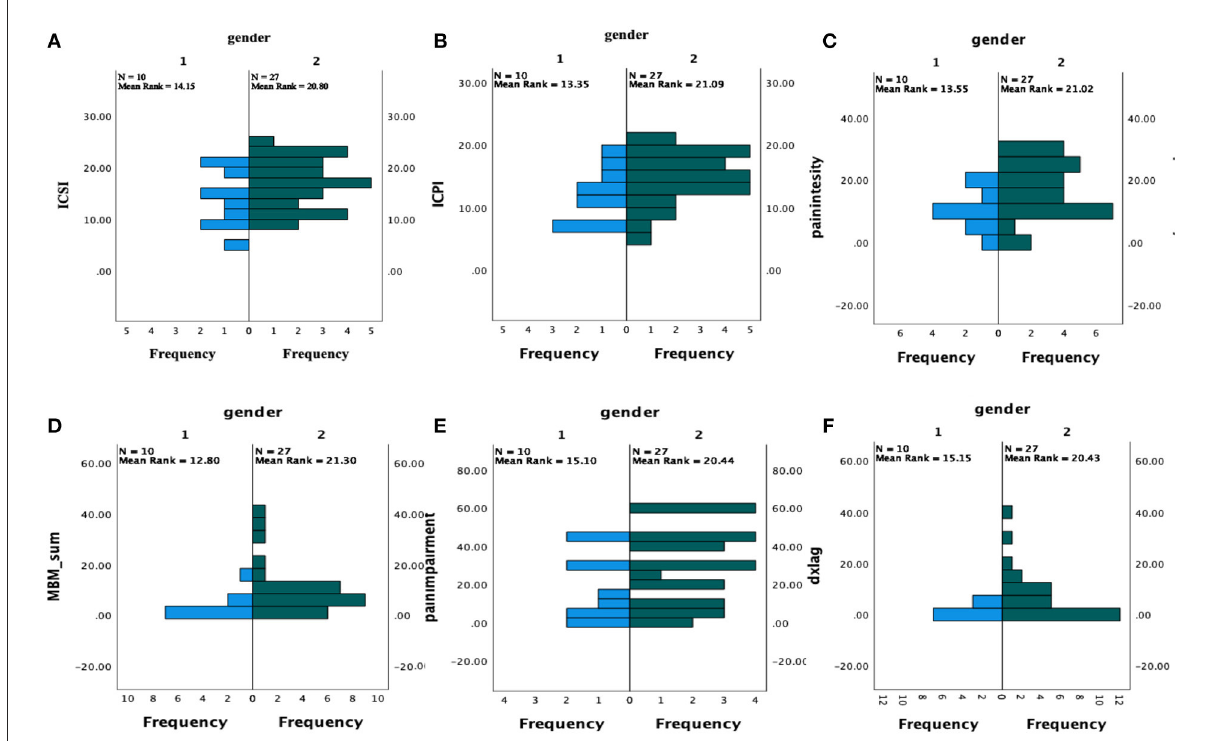
FIGURE3 Symptom comparison by Gender. 1 = men ( n = 10), 2 = women ( n = 27), ICSI, interstitial cystitis symptom index; ICPI, interstitial cystitis problem index; MBM, michigan body map; dxlag, time-to-diagnosis from symptom onset. (A) ICSI by gender; (B) ICPI by gender; (C) Intensity by gender; (D) Michigan body map pain area count; (E) Brief pain inventory impairment by gender; (F) Time lag between symptom onset and diagnosis by